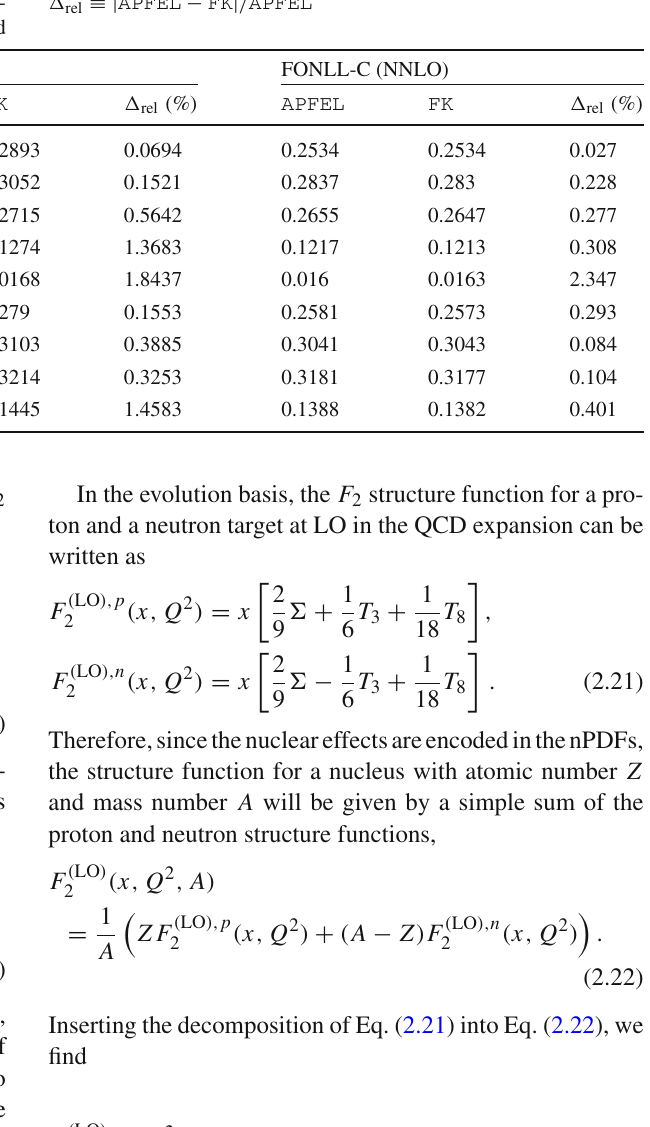
in the text. The values of x and Q 2 correspond to representative measurements for carbon ( A = 12) and lead ( A = 208) nuclei. Also given are the relative differences between the two calculations,